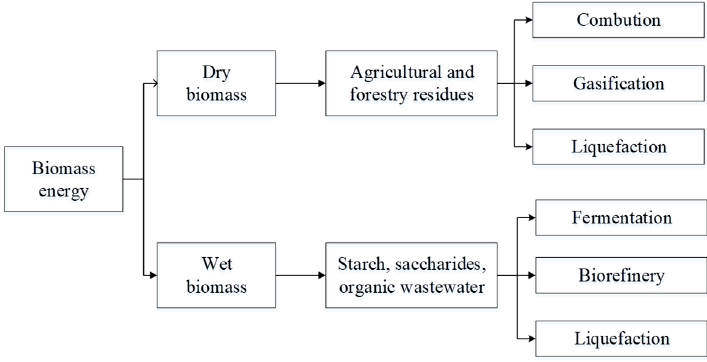
Figure 2. Current conversion technologies of biomass.